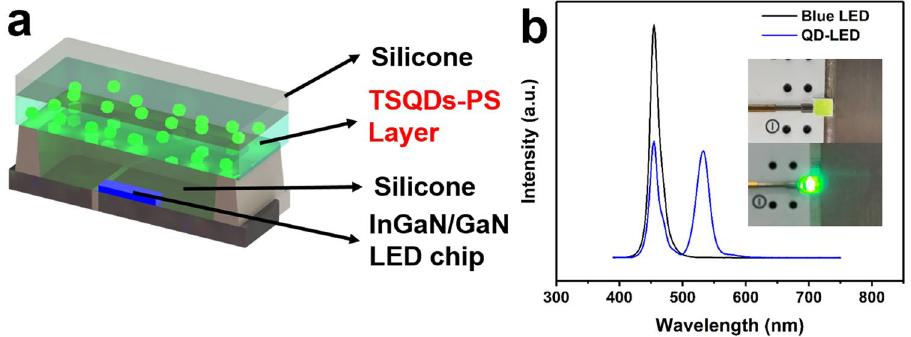
Figure 6. ( a ) Schematic of a remote packaging LED with green-emitting TSQDs; ( b ) the EL spectra of a blue LED and a green QD-LED operated at a current of 20 mA at 2.7 V, the inset is the photograph of green-emitting LED under daylight and operation at 20